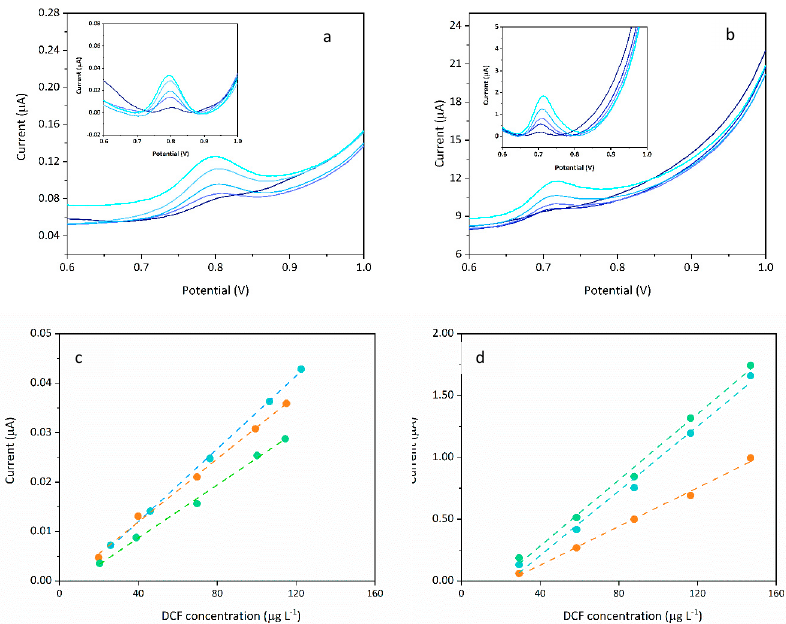
Figure 9. ( a ) Peaks obtained by drop DPV analysis with aSPCE1 on 25–120 µg L − 1 DCF solutions (1.0 × 10 − 1 mol L − 1 PB, pH 2.0; E vs. Ag/AgCl); the inset graph shows the peaks after baseline subtraction; ( b ) Peaks obtained by drop DPV analysis with aSPCE2 on 29–147 µg L − 1 DCF solutions (1.0 × 10 − 1 mol L − 1 PB, pH 2.0; E vs. Ag/AgCl); the inset graph show the peaks after baseline subtraction; ( c ) linear fit of signals recorded by drop DPV analysis with aSPCE1 on 25–120 µg L − 1 DCF solutions; ( d ) linear fit of signals recorded by drop DPV analysis with aSPCE2 on 29–147 µg L − 1 DCF solutions. The value of the LoD and LoQ estimated for aSPCE1 and aSPCE2 were, respectively, 9 µg L − 1 and 28 µg L − 1 , and 15 µg L − 1 and 45 µg L − 1 .